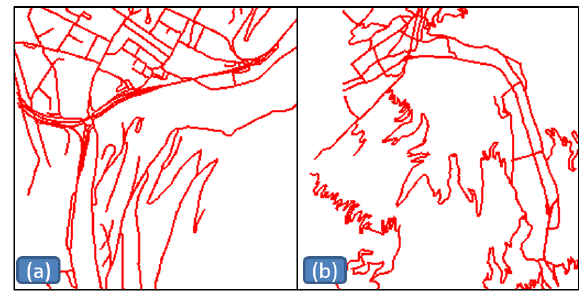
Figure 5: Two images of maps with only mountain roads at dif- ferent scales: (a) 1:25,000 scale (b) 1:250,000 scale.